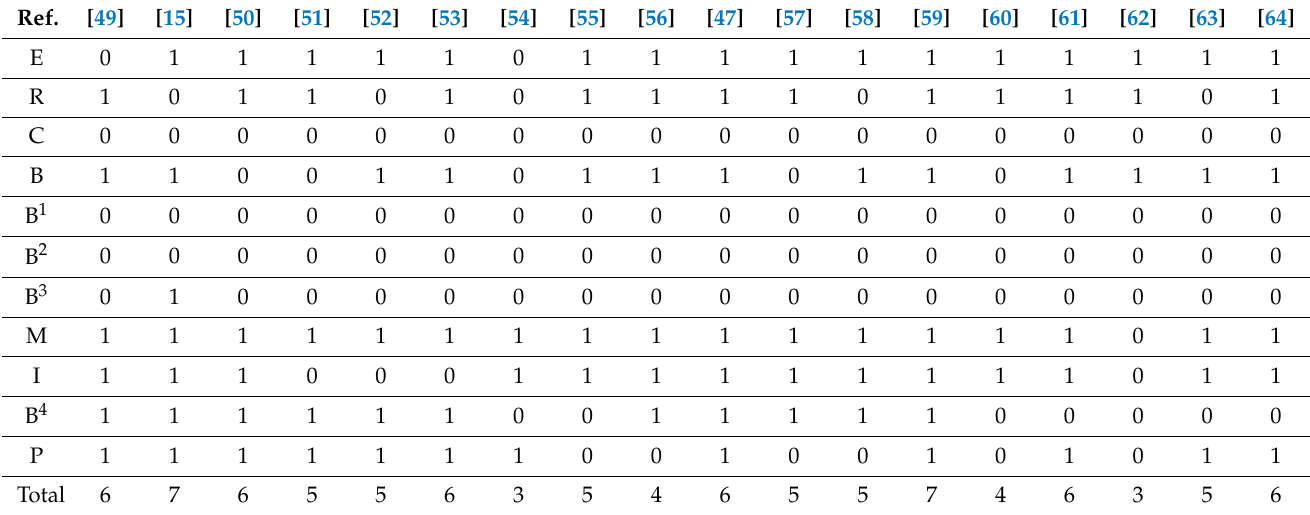
Table 1. Scores of methodological quality assessment of the included studies based on the PEDro scale.